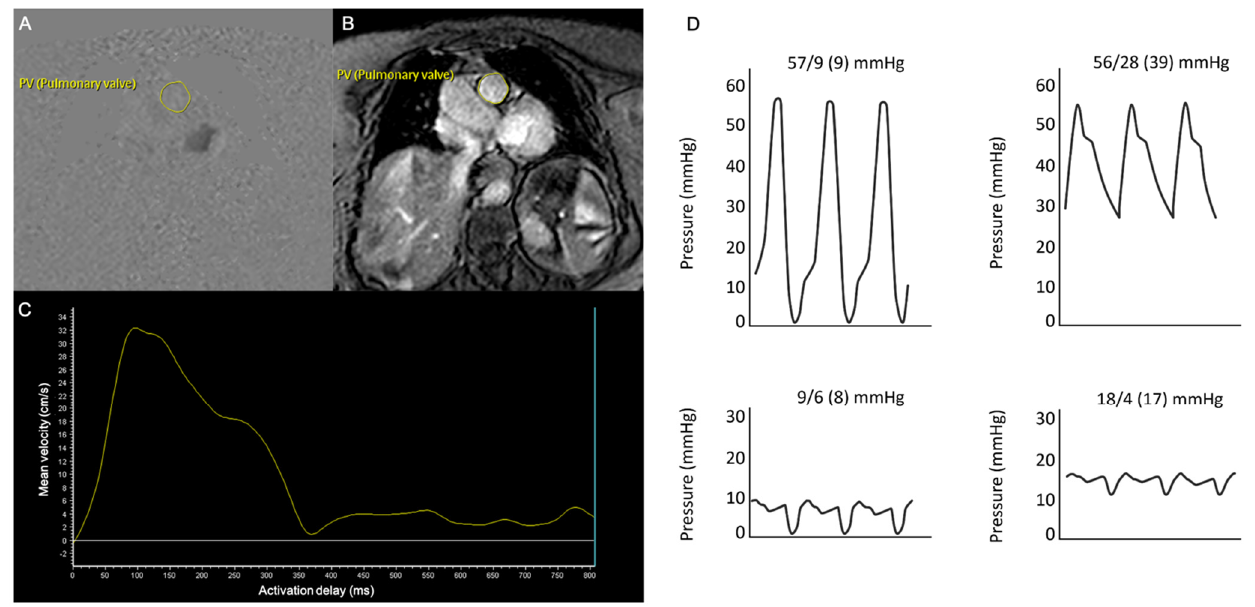
Figure 1. Cardiac magnetic resonance and right heart catheterization examinations of a representative patient. ( A , B ) Velocity-encoded gradient echo sequences on an axial section of the main PA. ( C ) Offline analysis of PA flow rate vs. time to calculate average and peak PA velocities. ( D ) Right chamber’s pressures determined by right heart catheterization.